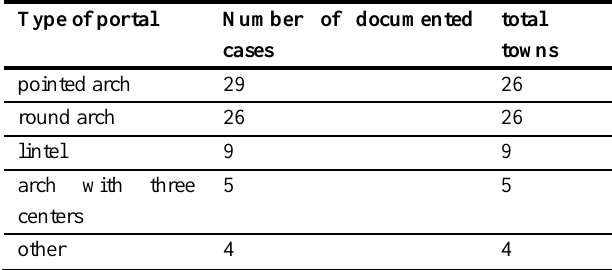
Table 1. Portals distinct according to the geometric shape.